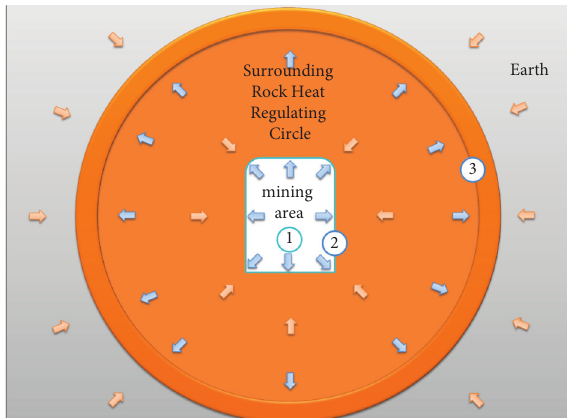
Figure 1: Schematic diagram of heat transfer in the heat-regulating circle of the surrounding